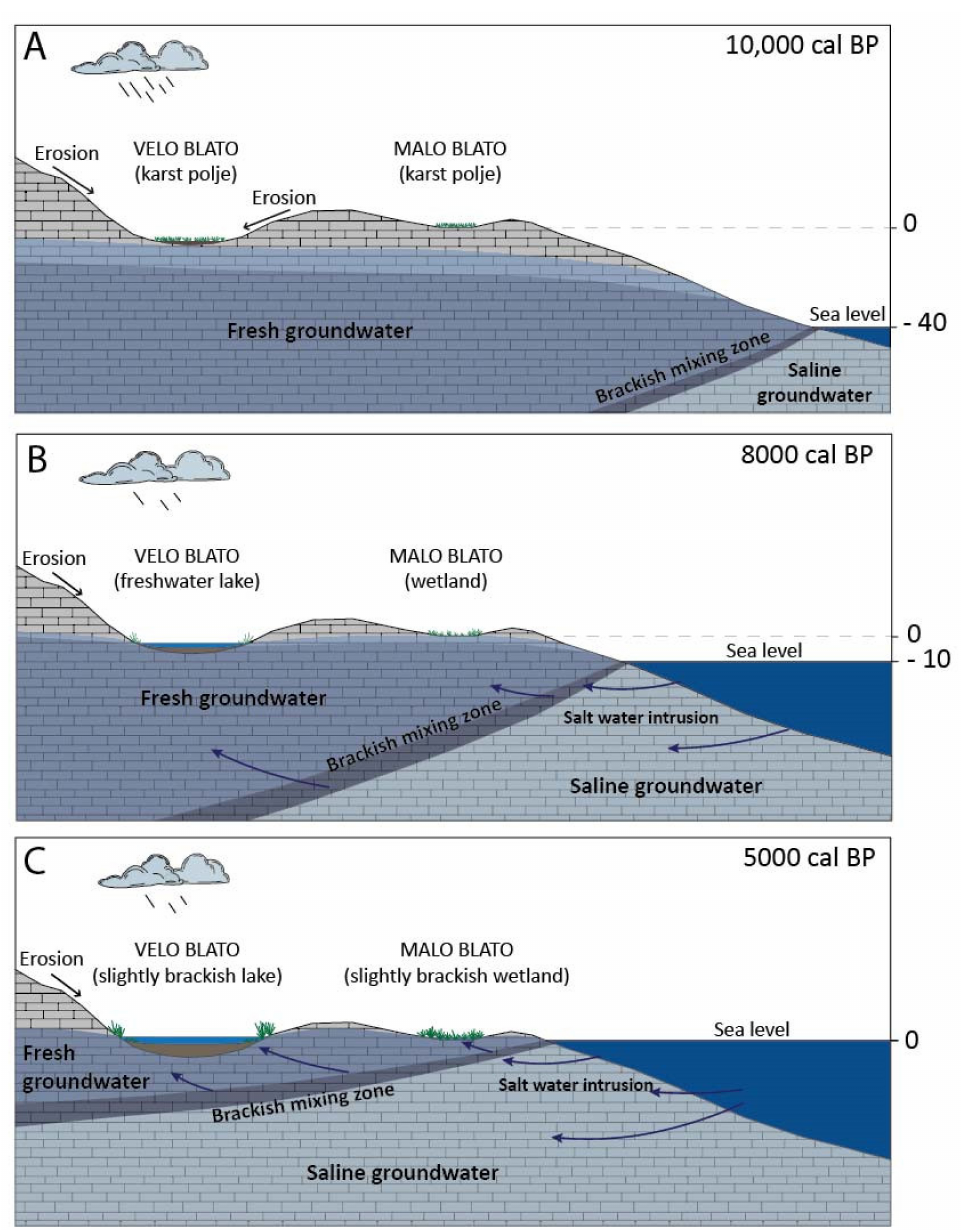
Figure 13. Schematic presentation of seawater intrusion into freshwater coastal lakes and wetlands, caused by the sea-level rise, on the example of Velo and Malo Blato in the last 10,000 years. ( A ) Velo and Malo Blato as karst poljes during the Early Holocene lowstand. ( B ) Sea-level rise in the Adriatic Sea resulted in rising the groundwater level and the formation of a freshwater lake in Velo Blato at approximately 8100 cal year BP, and the formation of a wetland in Malo Blato. ( C ) Saltwater intrusion and saline groundwater influence on lake sediments in Velo Blato in Middle Holocene at 5000 cal year BP (started from 7100 cal year BP), resulting in brackish environments in Lake Velo and wetland Malo